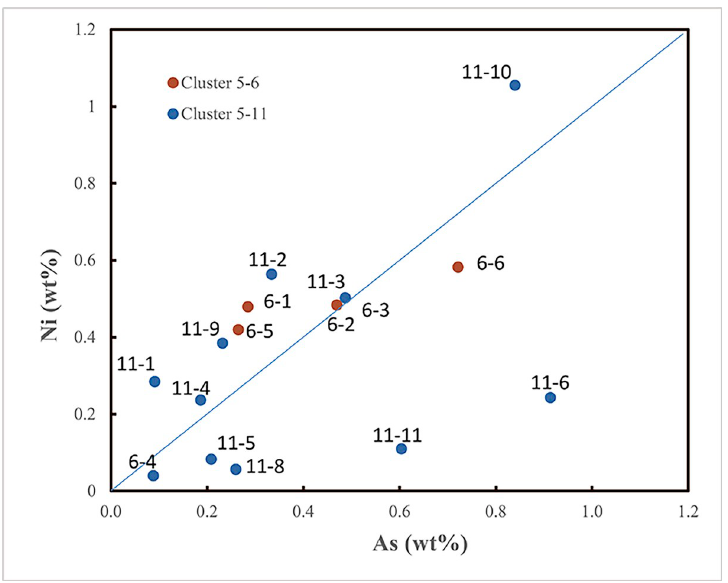
Fig 8. The subdivision of cluster C#5 is visible in the As/Ni diagram. The study presented used the subdivision into eleven subclusters as a guide to define these artefact groups with a significant Ni = As balance.